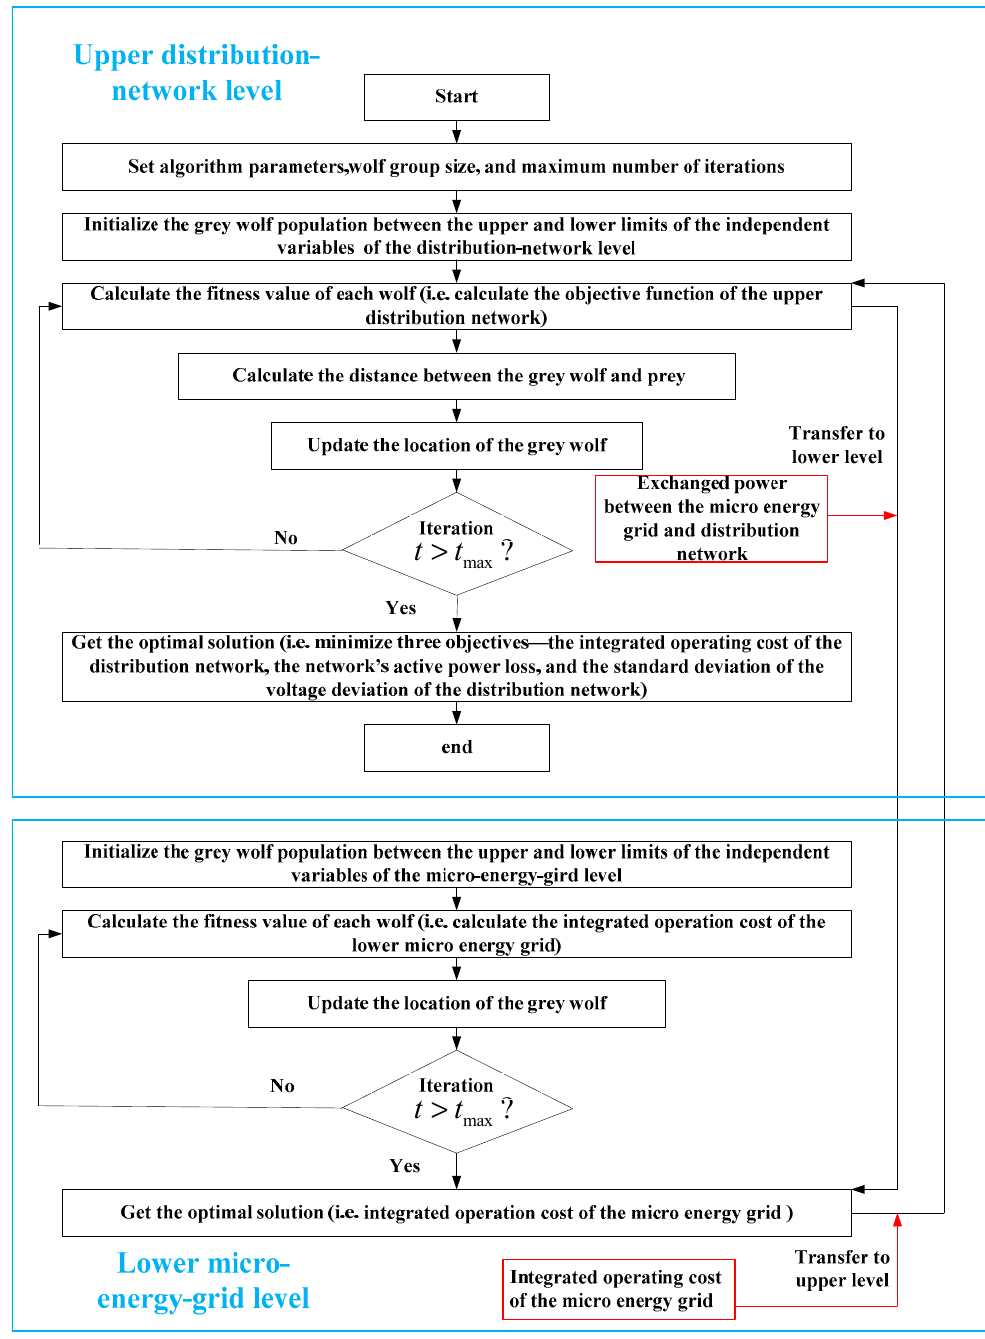
Figure 4. Flow chart of the bi-level optimal model of the distribution network comprising the micro energy grid, based on the improved GWO algorithm.